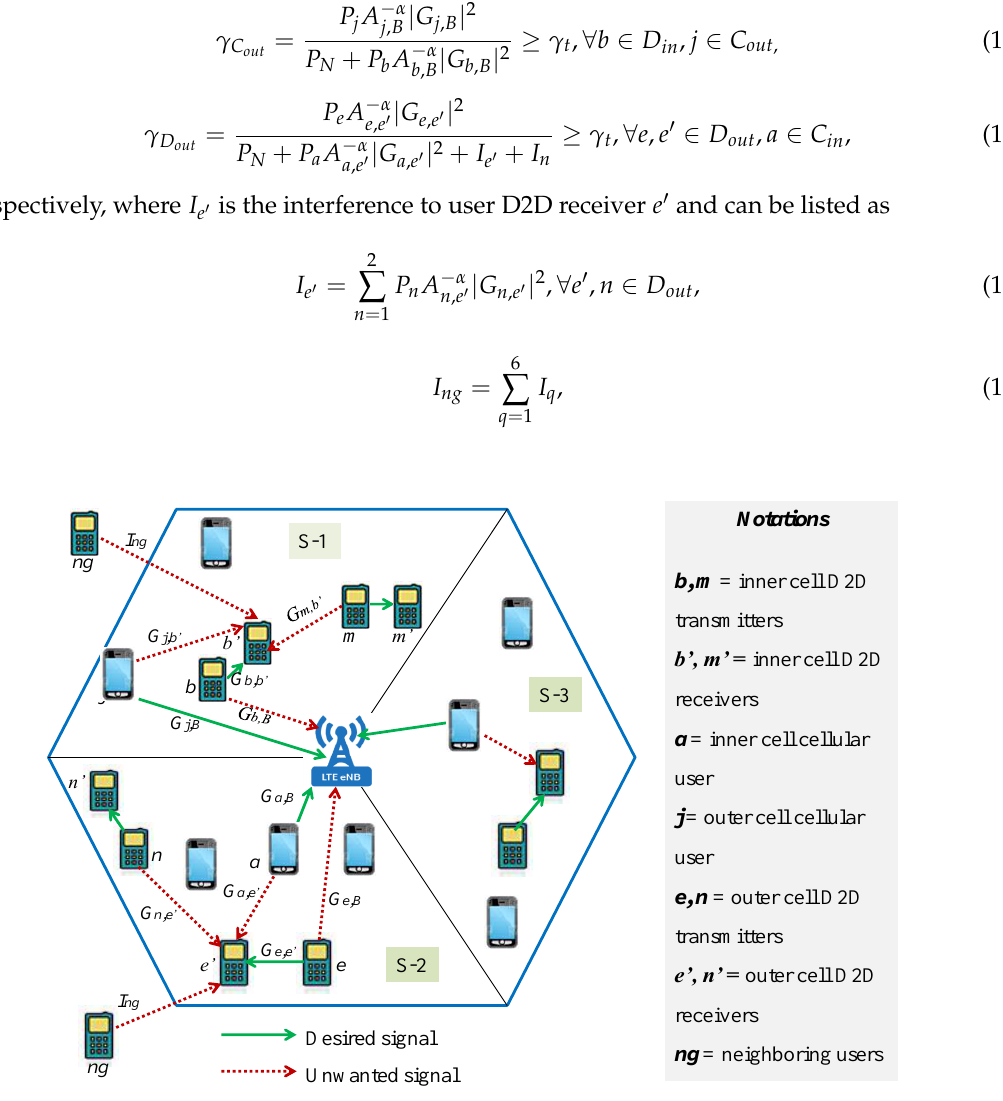
Figure 3. Single uplink cellular resource reused by one D2D pair.